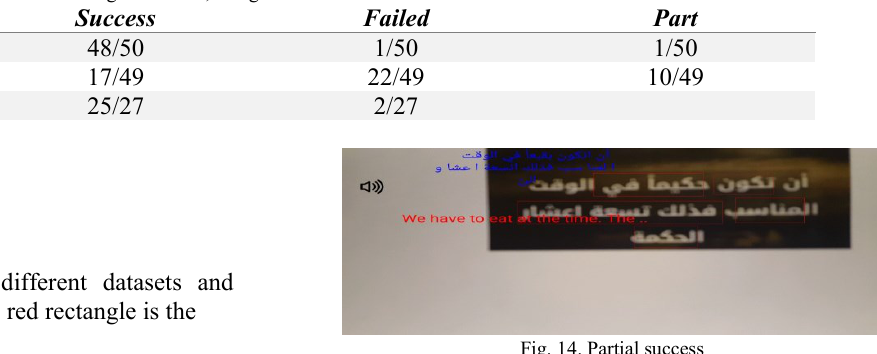
Table 6. Number of images detected, recognized and translated in real-world dataset